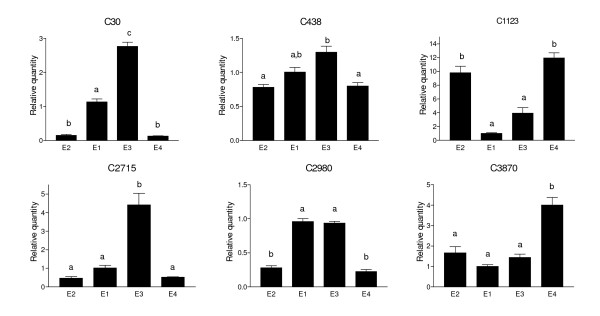
Relative quantity of transcript levels in response to long-term cold storage, ripening, as well as the combination of these two factors. The qPCR data was obtained by analyzing the transcript level of contigs 30, 438, 1123, 2715, 2980 and 3870) under four post-harvest conditions, normalized against a gene which did not demonstrate significant variations in transcript levels (Dehydrogenase/GMP reductase, contig 2766). Graphed qPCR data represents the mean transcript level of three or four individual fruits ± the standard error. E1 = non-ripe; no long-term cold storage = R-, C-; E2 = ripe; no long-term cold storage = R+, C-; E3 = non-ripe; long-term cold storage = R-, C+; E4 = ripe: long-term cold storage = R+, C+. contig30: Wcor; contig438: dormancy-associated protein (DRM1); contig1123: polygalacturonase; contig2715: luminal binding protein 1 (BIP-1); contig 2980: temperature-induced lipocalin (TIL) and contig 3870: lipoxygenase.